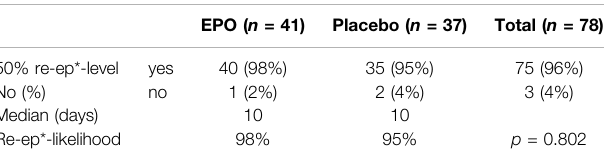
TABLE 2 | Overview of the results of the 50% re-epithelialization level of the study